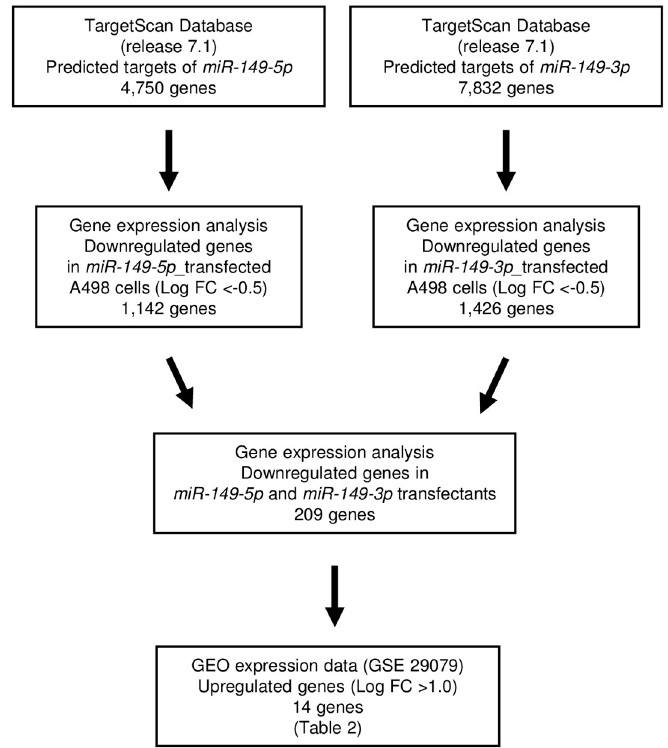
Figure 3. The strategy underlying the analysis of miR-149-5p and miR-149-3p target genes in A498 cells. FC: fold-change.